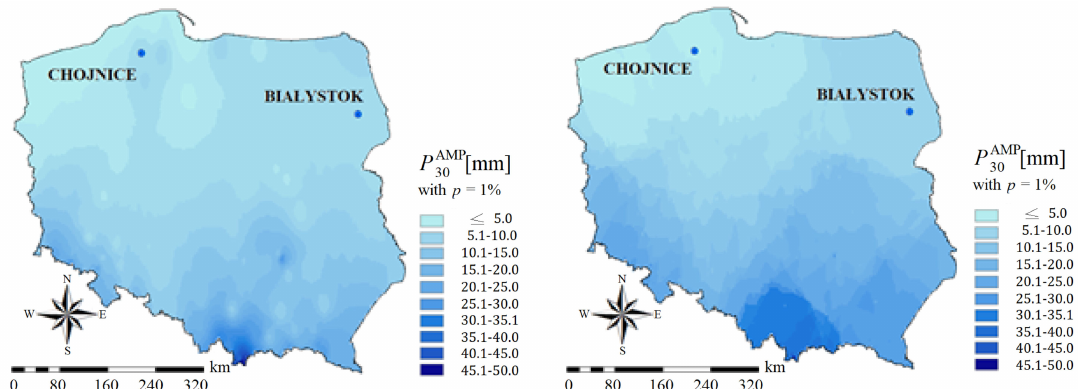
Figure 18. Interpolation of maximum precipitations computed using the PMAXTP model for the random variable P AMP τ with durations τ = 30 min with probability of exceedance p = 1% using IDW method ( left part) and kriging method ( right part) for the Bialystok and Chojnice meteorological